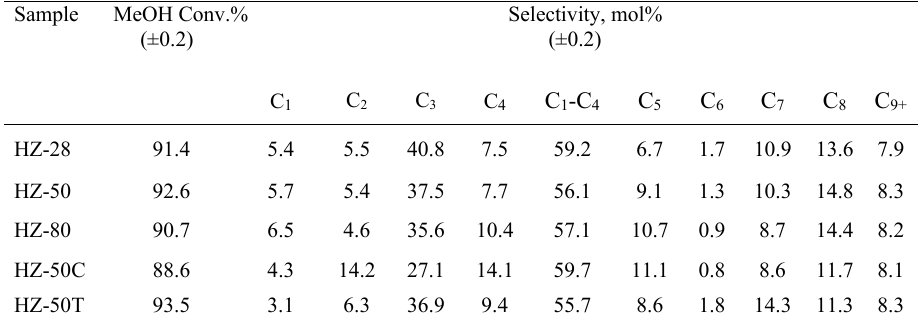
Table. 5. Conversion percent and selectivity of the products based on the number of carbons in MTH process at P = 1atm, T = 400 ºC, WHSV = 3 h